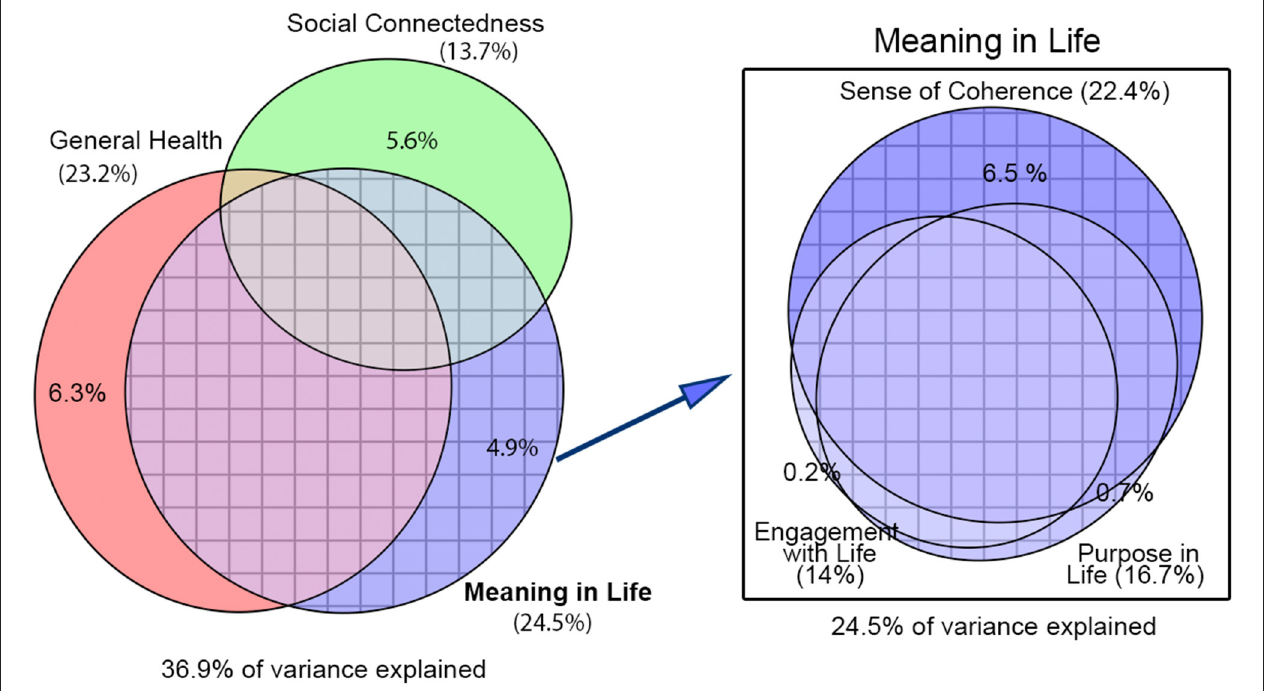
FIGURE 2 | Elliptical Venn diagrams with overlapping and non-overlapping areas proportional to the total variance in loneliness explained by each group of risk factors. Figures in parentheses correspond to the explained variance when we do not control for the other risk factors represented (total area of the ellipses). Figures without parentheses correspond to the variance when we control for them (non-overlapping areas of the ellipses). Socio-demographic factors have always been partialed out to account for sampling selection biases in our